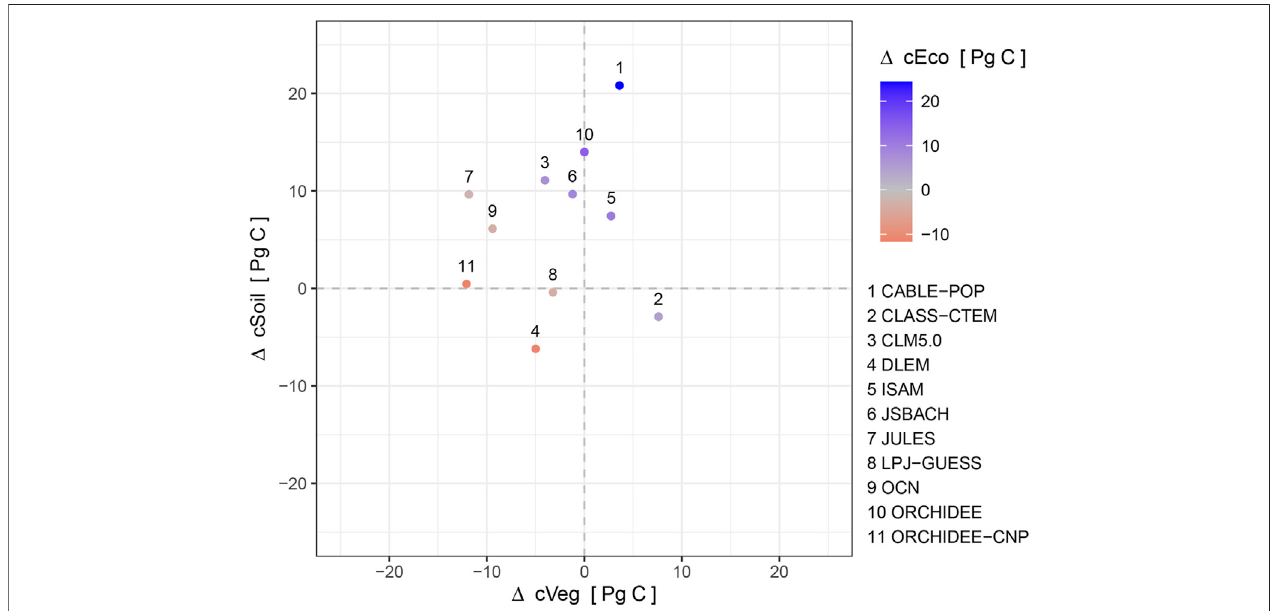
FIGURE7 | Comparison of changes in simulated vegetation and soil carbon in global drylands from 1901 to 2018. Points are coloured by the net change in ecosystem carbon, illustrating the diversity of model predictions within the ensemble.